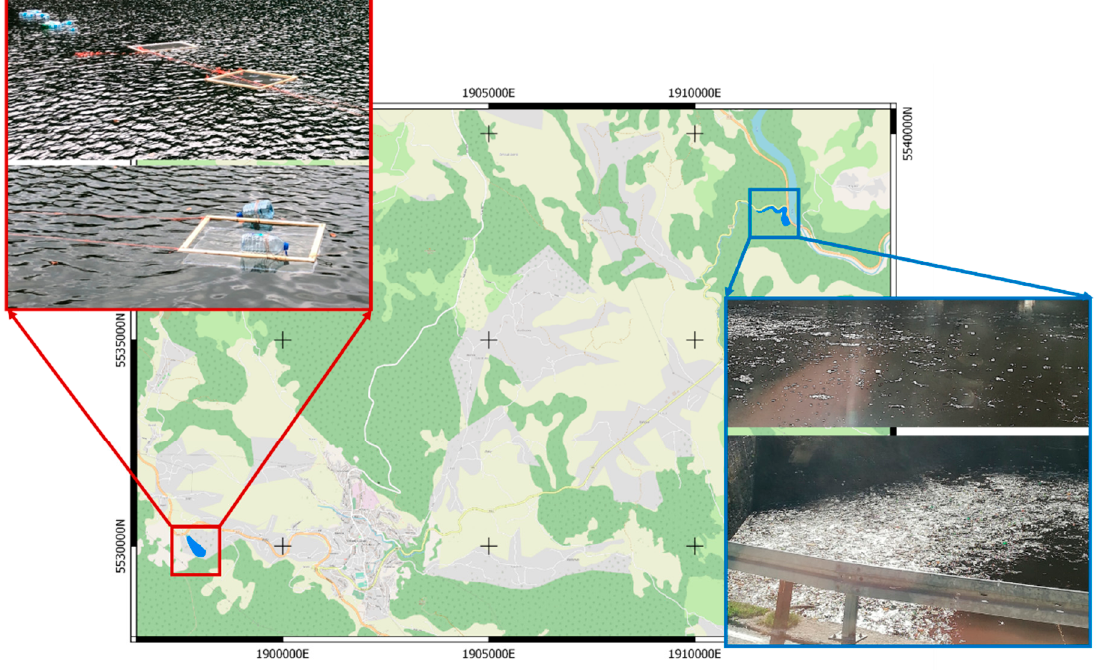
Figure 1. Study areas: Lake Balkana (left) and Crna Rijeka River (right). EPSG:3857.